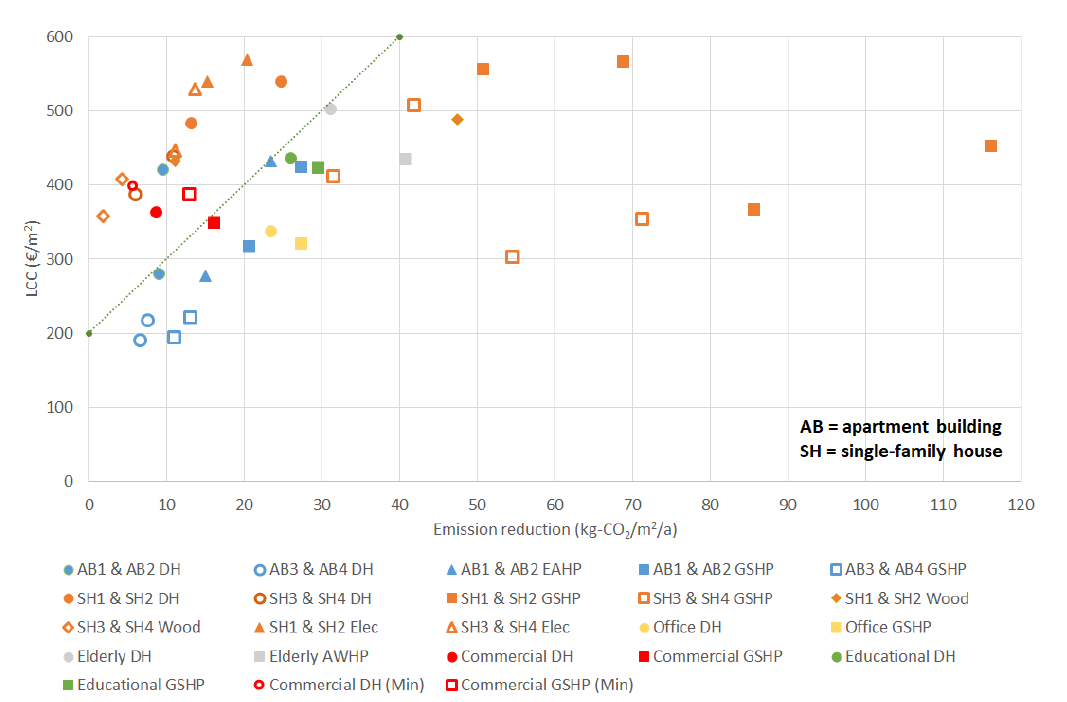
Figure 5. Life cycle cost for different levels of emission reduction. Buildings 2020 , 10 , x FOR PEER REVIEW